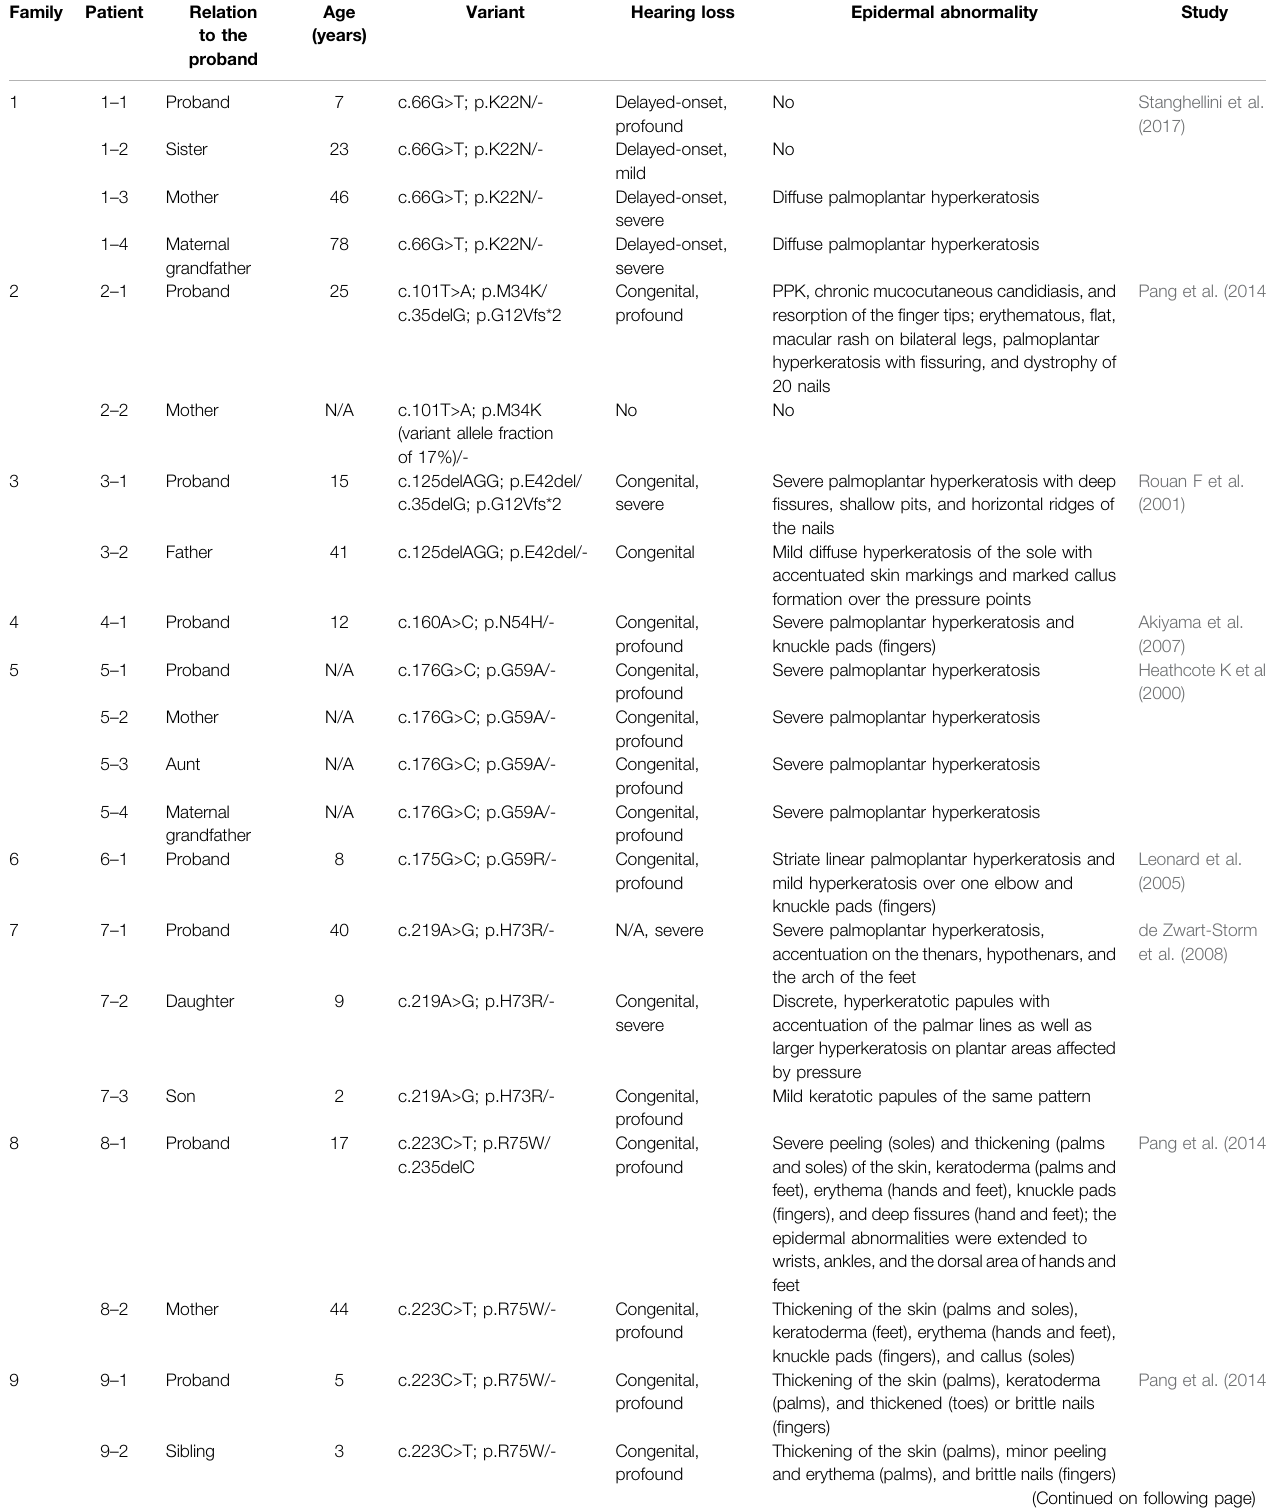
TABLE 1 | Clinical phenotypes of PPKDFN patients with the variation reported in the GJB2